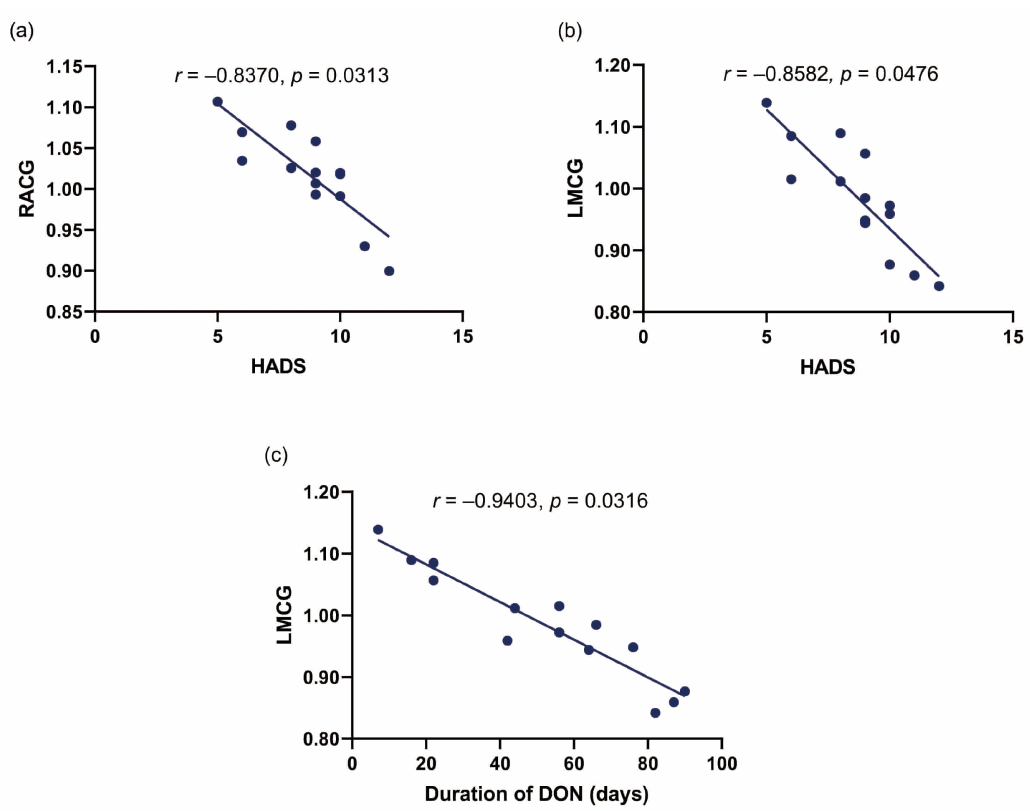
Fig. 4. Pearson’s correlation analysis of relationships between the fALFF values of brain regions and clinical behaviors in the DON group. (a) The mean fALFF value of the RACG showed negative correlations with the HADS score ( r = –0.8370, p = 0.0313). (b) There was a negative correlation between mean fALFF value of the LACG and HADS score ( r = –0.8582, p = 0.0476). (c) The mean fALFF value of the LMCG was negatively correlated with the duration of DON ( r = –0.9403, p = 0.0316). fALFF, fractional amplitude of low-frequency fluctuation; DON, diabetic optic neuropathy; RPCG,